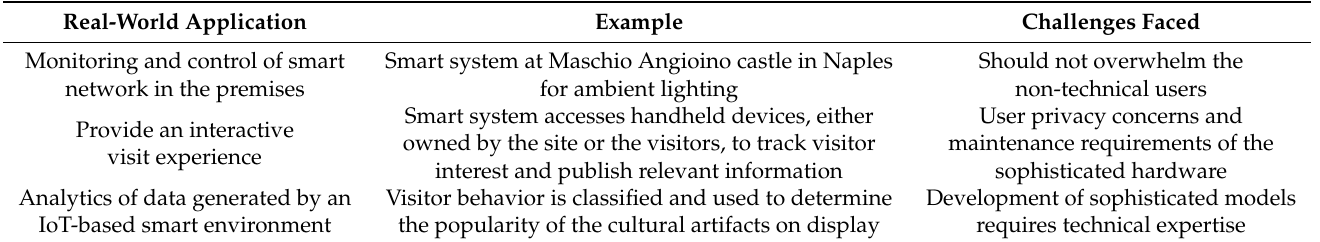
Table 1. Existing applications of IoT in cultural heritage